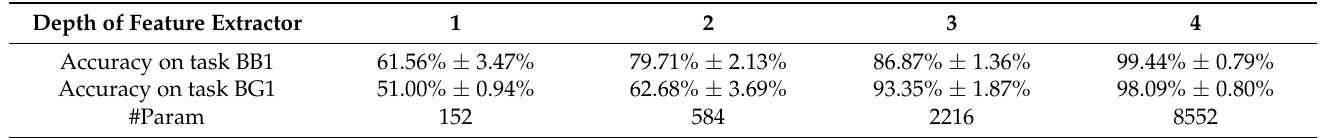
Figure 10. The cross-domain fault diagnosis using the feature extractor with different depths: ( a ) on the three-way one-shot task BB1; ( b ) on the two-way one-shot task BG1. Table 11. The detailed one-shot cross-domain fault diagnosis result (average accuracy and standard deviation) and #Param using the feature extractor with different